Question: What does this figure show? Answer in one sentence.
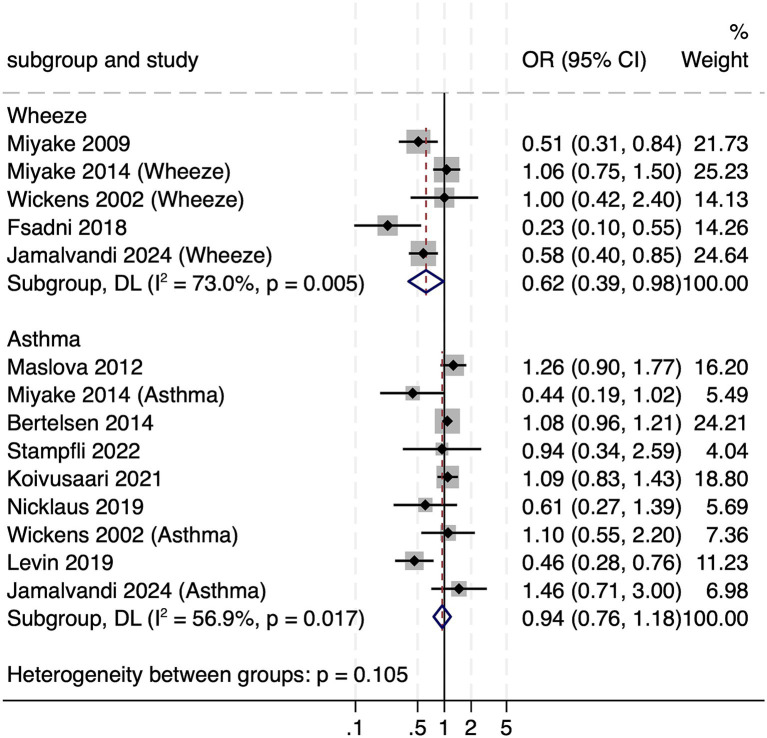
Answer: Forest plot of subgroup analysis by respiratory phenotype.